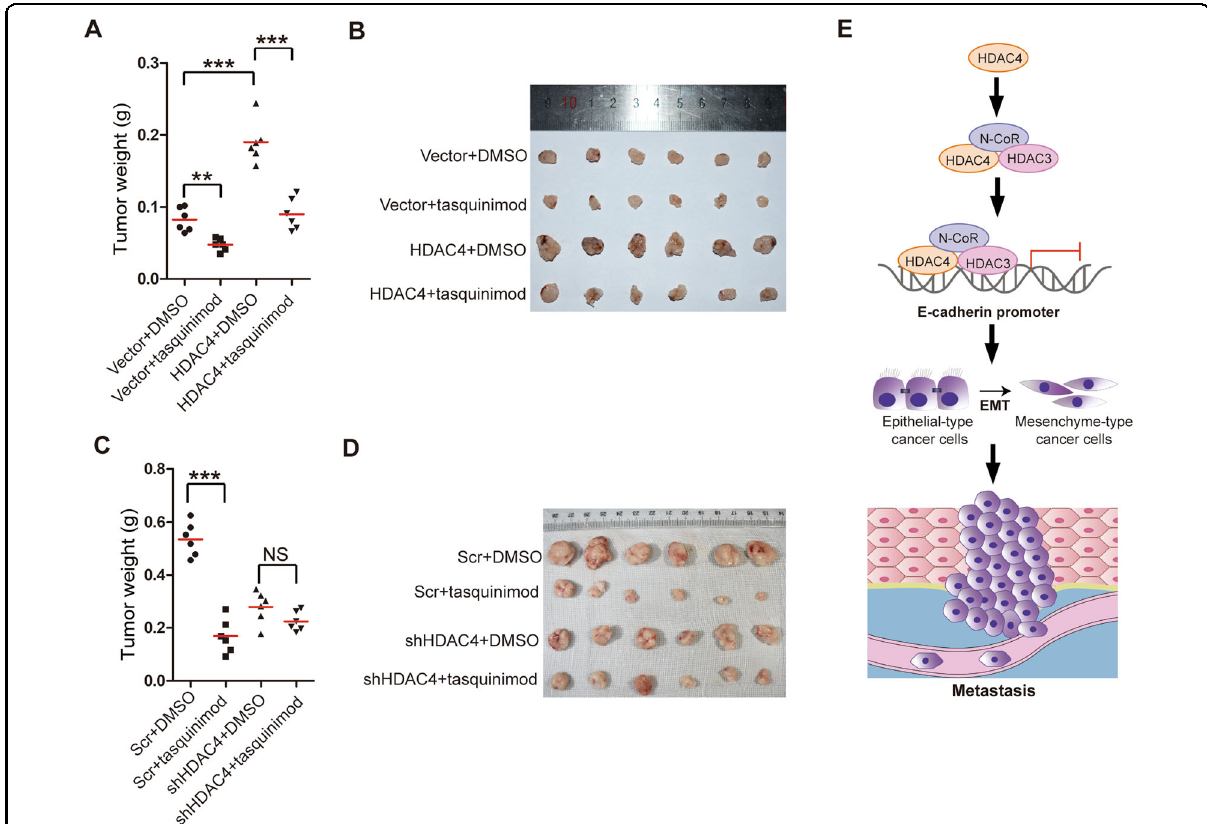
Fig. 7 Tasquinimod suppresses the HDAC4-induced promotion of tumor growth in vivo. A – D The tumor weights (left) in nude mice after the subcutaneous injection of 6-10B-Vector, 6-10B-HDAC4, 5-8F-Scr, or 5-8F-shHDAC4 cells treated with tasquinimod or vehicle (DMSO) ( A , C ). The image on the right is the tumor image ( B , D ). The data are presented as means ± SD. Student ’ s t -test, ** P < 0.01,*** P < 0.001. NS: nonsigni fi cant. E Proposed model of the role of HDAC4 in promoting tumor metastasis in NPC by binding the promoter of E-cadherin to induce